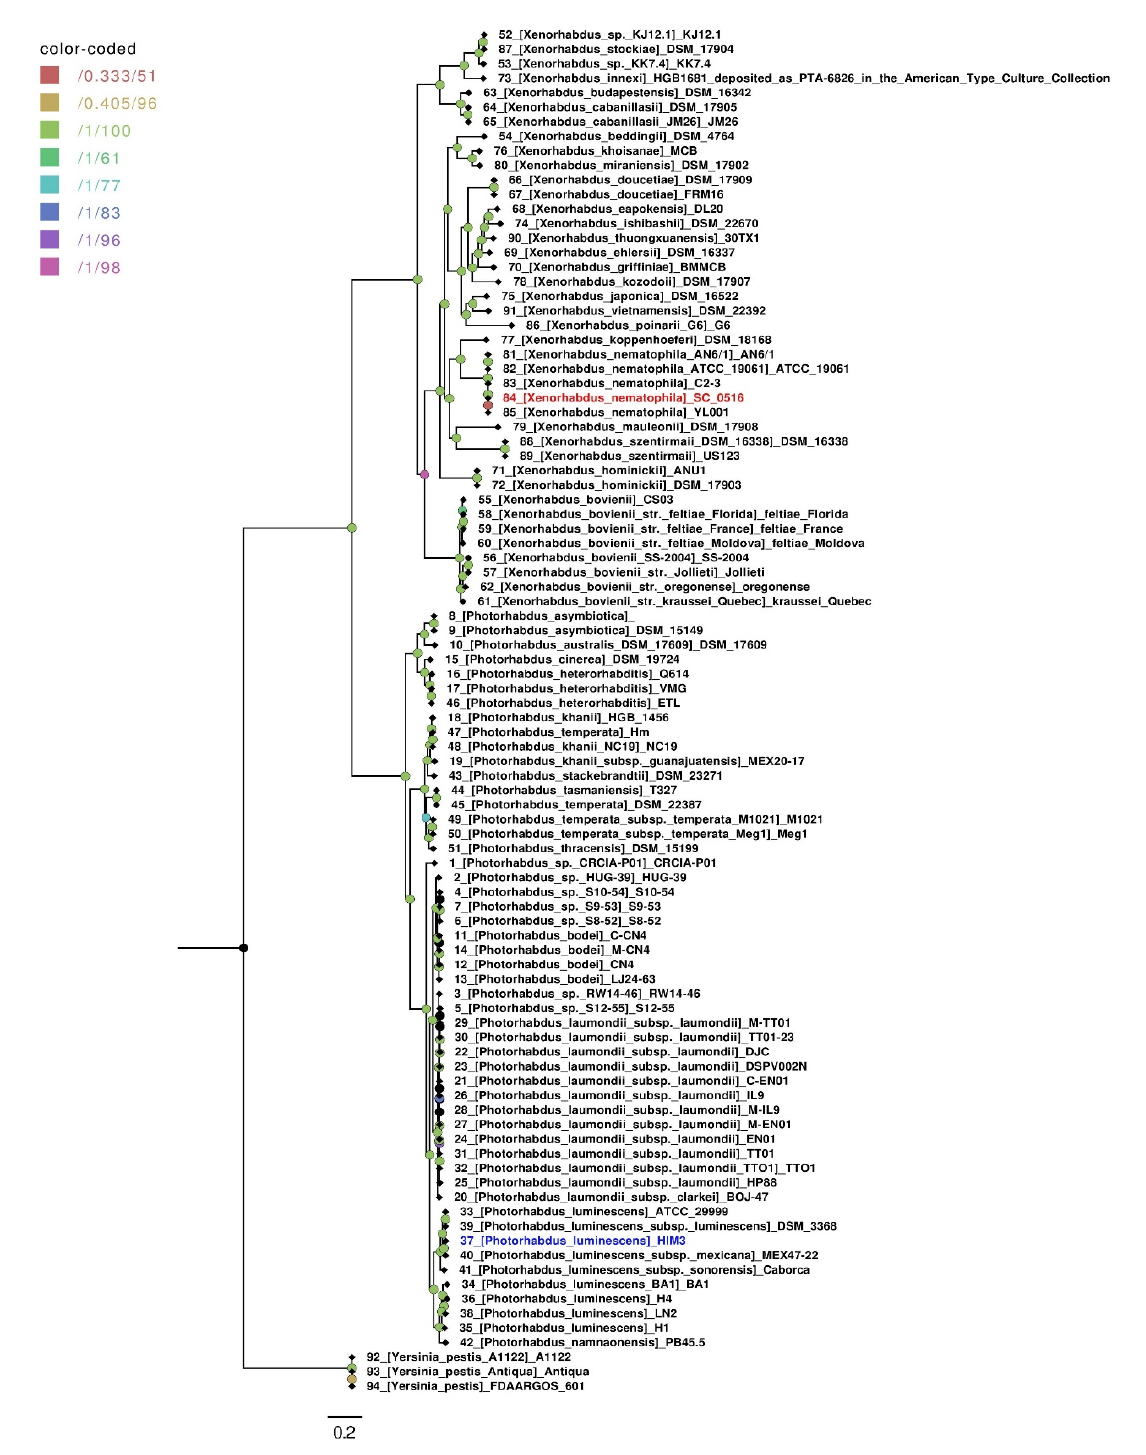
Figure 3. Maximum likelihood (ML) core genome phylogeny. The ML tree is based on 281 consensus protein-coding genes defined by the GET_HOMOLOGES package and filtered through GET_PHYLOMARKERS, selected for their optimal phylogenetic attributes. Nodal support values are color-coded as shown in the legend. The first value corresponds to approximate Bayesian support values, whereas the second one corresponds to ultrafast bootstrap values, as implemented in IQTREE. The scale represents the number of expected substitutions per site under the best-fit GTR2+F+R3 (binary) model. The phylogeny corresponds to the tree with the highest score (lnL = − 3,045,265.731) found among 10 independent searches in IQTREE.